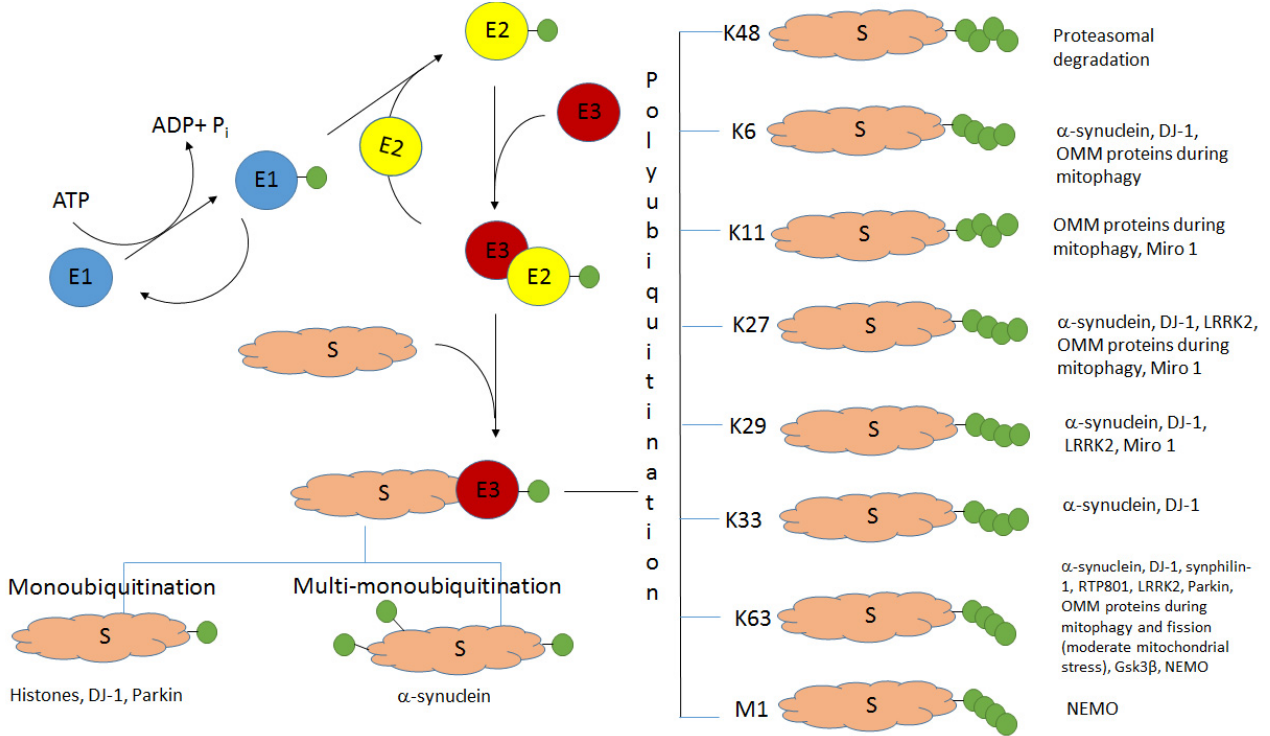
Figure 1. The scheme of ubiquitination and the role of different types of ubiquitination in PD. S— Figure 1. Examples of crystal structures of homotypic ( a , d ) and heterotypic ( b , c ) tri-ubiquitin protein substrate, E1—ubiquitin-activating enzyme, E2—ubiquitin-conjugating enzyme, E3—ubiq- chains available in the Protein Data Bank (PDB). ( a ) K27-linked tri-ubiquitin (PDB uitin ligase. Ubiquitin molecules are shown as green circles. Adapted from [35 ] .